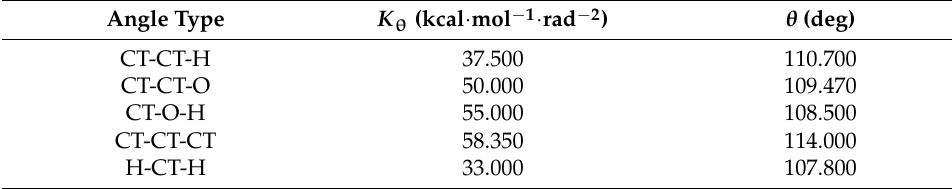
Table 3. Angle bending parameters for alcohols.